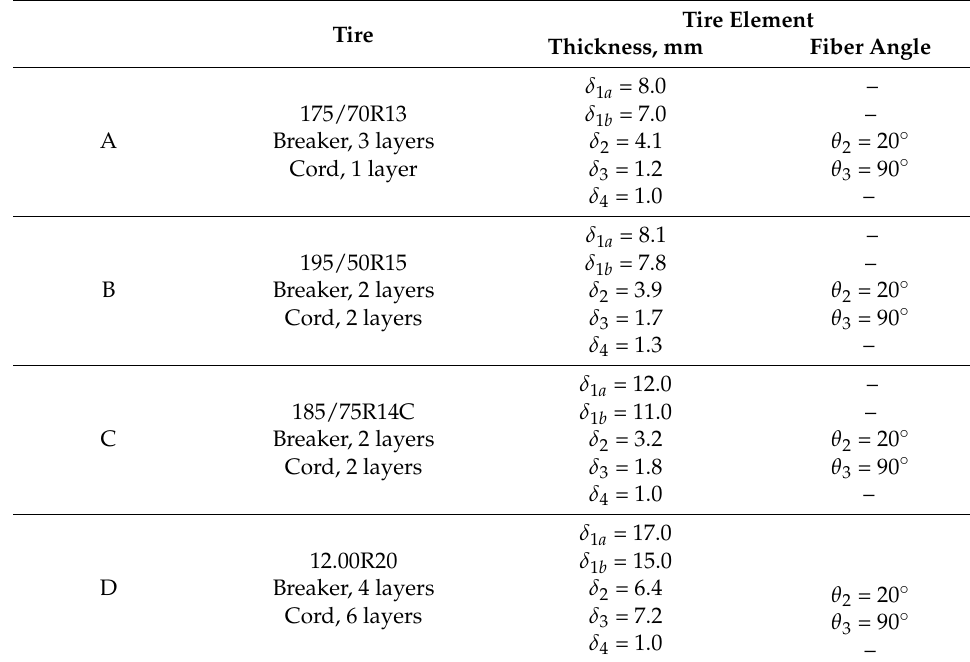
Figure 3. Tire load scheme: ( a ) tire deformation not assessed; ( b ) tire deformation assessed. Table 1. Data of the tire components.